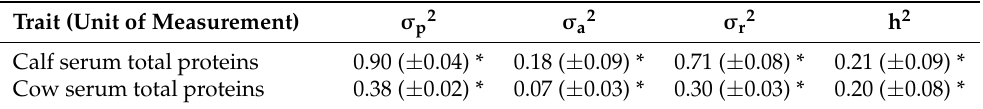
Table 3. Variance component and heritability estimates of cow and calf serum total proteins (%Brix